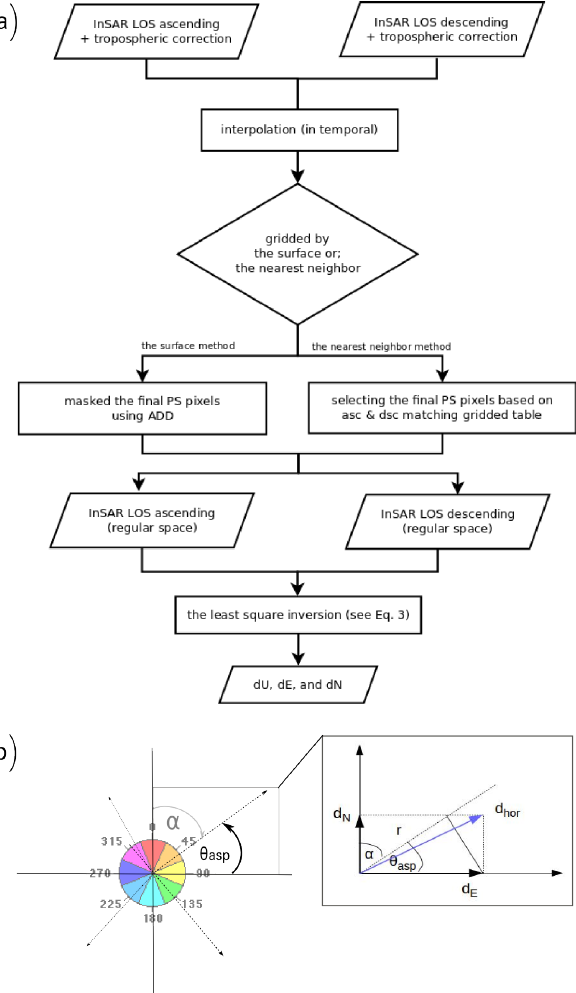
Figure 2. a) The strategy to estimate 3D vector displacements using the different tracks of InSAR data and the slope aspect.